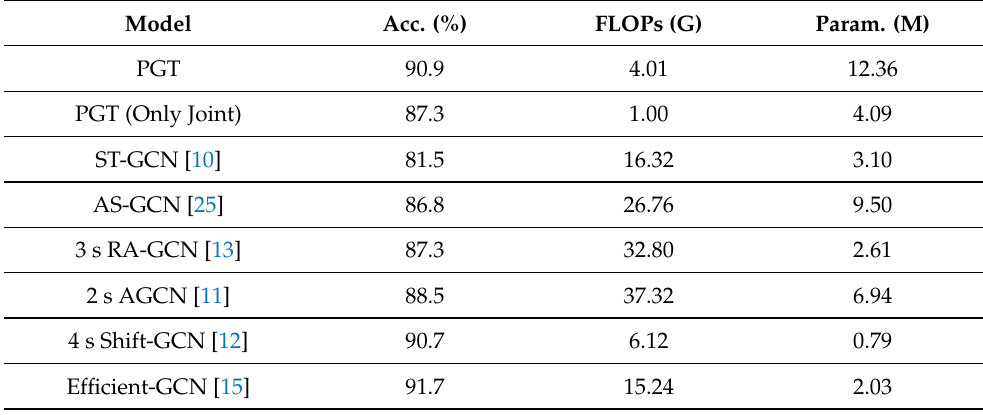
Table 8. The model complexity on the NTU-RGBD 60 CS benchmark denoting the efficiency of the